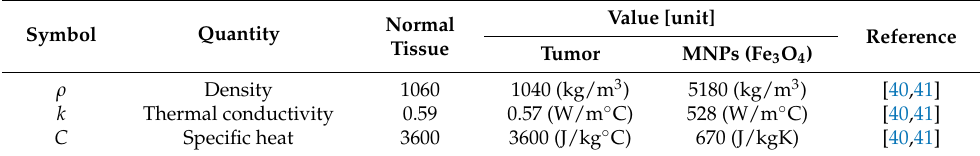
Table 1. Parameters of the biological